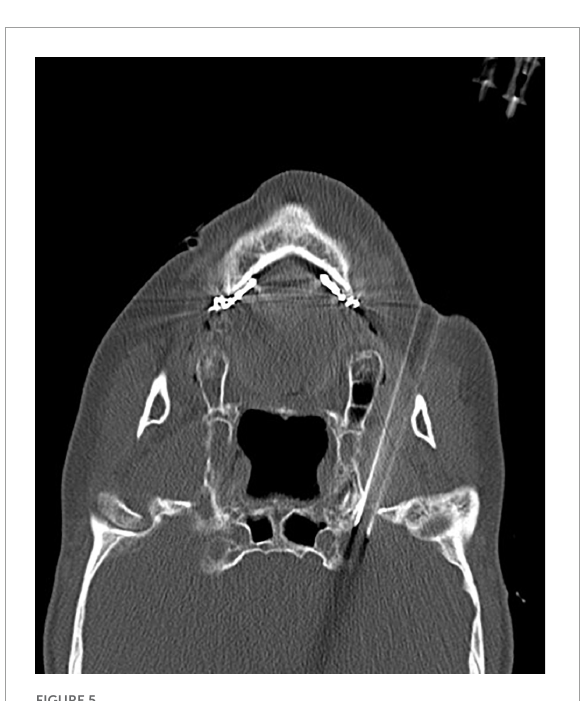
FIGURE5 Two puncture needles are inserted into the foramen